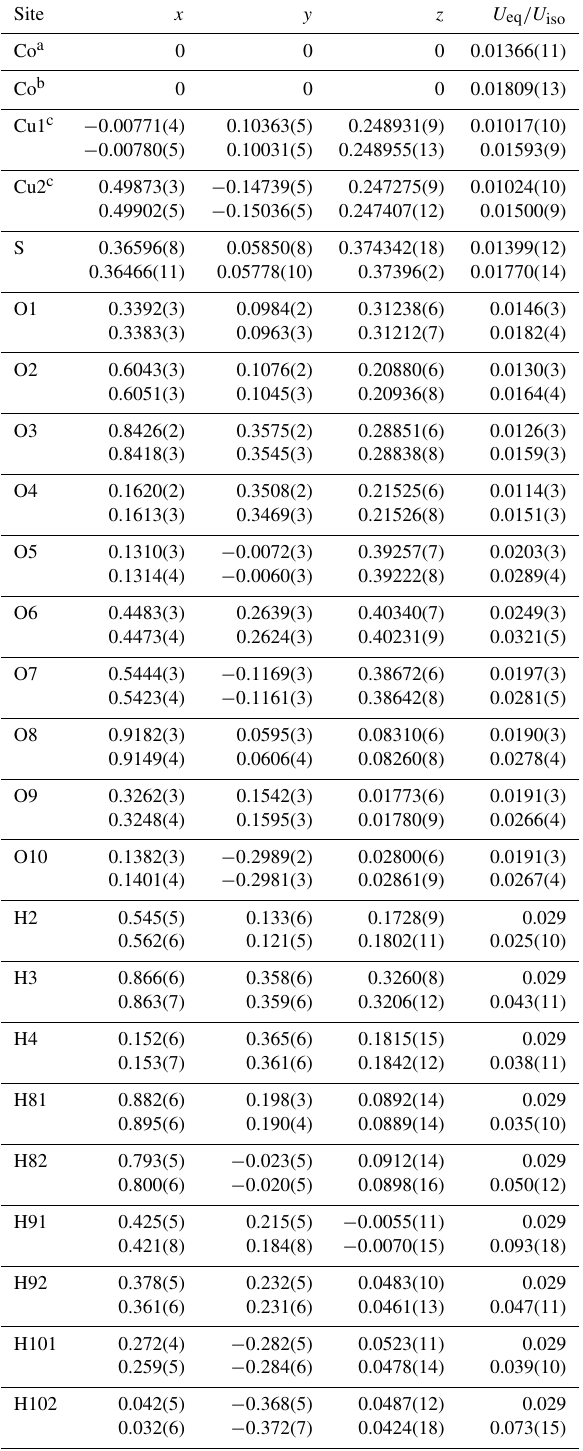
Table 3. Atom coordinates and equivalent/isotropic displacement parameters (Å 2 ) for gobelinite from Cap Garonne (every first line) and Eisenzecher Zug (every second